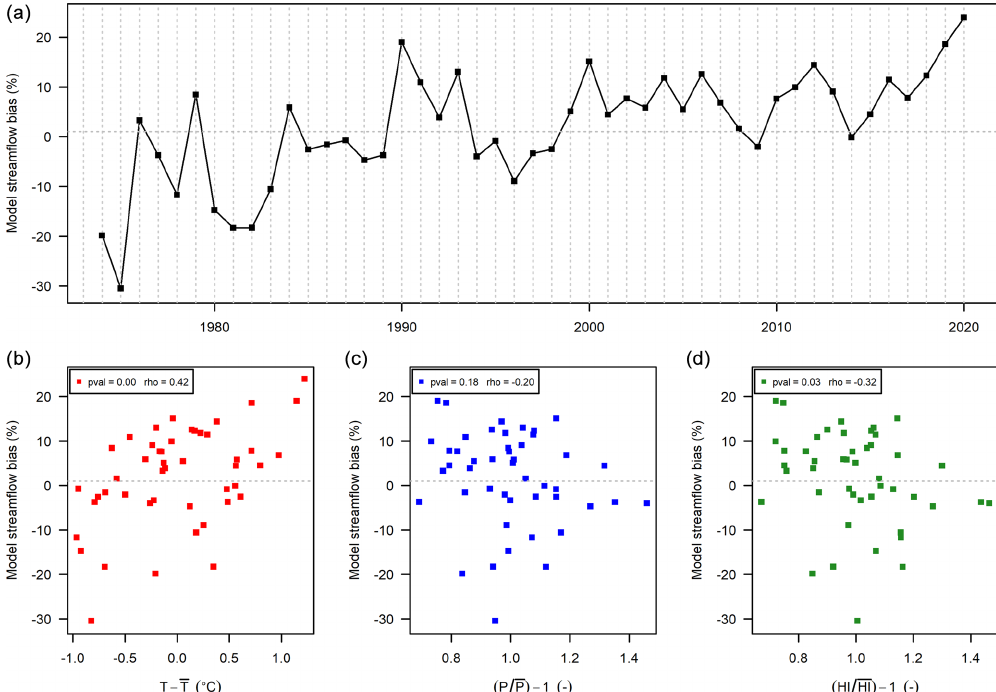
Figure 10. Streamflow annual bias obtained with the RAT function of time (a) , temperature absolute changes (b) , and precipitation P (c) and humidity index P/E 0 (d) anomalies, for the Briance River at Condat-sur-Vienne (L0563010) (597km 2